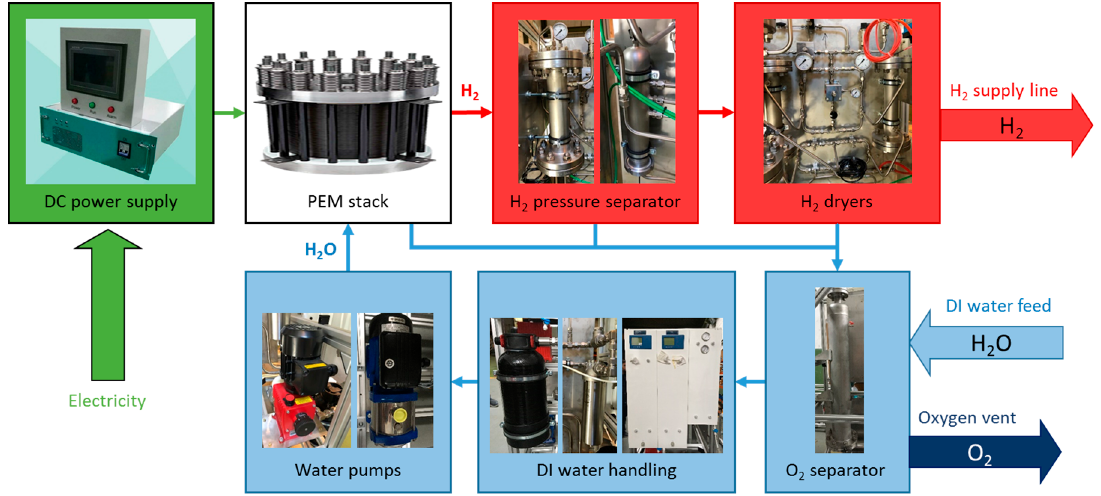
Figure 3. Block diagram of PEM electrolysis process.